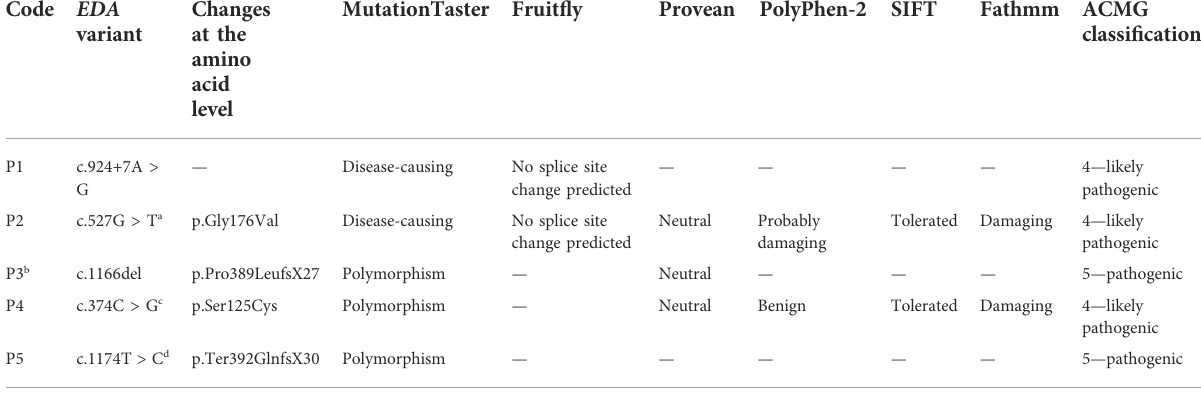
TABLE 2 EDA genotypes of affected individuals and assessments of variant effect prediction tools. Code EDA